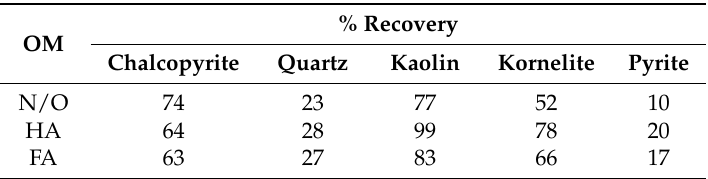
Table 2. Mass balance of Cu–Mo bulk concentrates without (N/O) and with 20 mg/L of humic or fulvic acid (from X-ray diffraction (XRD) analysis).